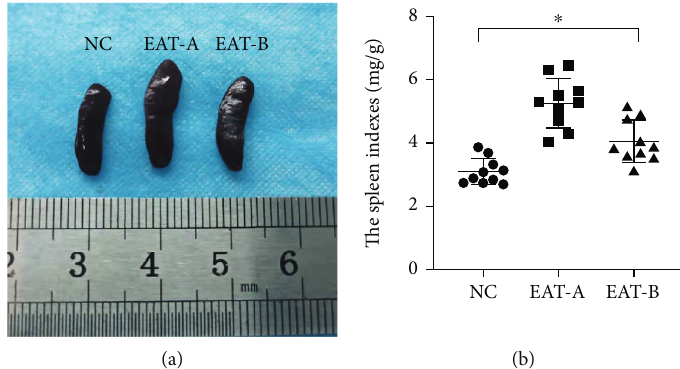
Figure 4: Spleen size and spleen index of mice at the end of the experiment. (a) Comparison of spleen size among the three di ff erent groups. (b) Comparison of the spleen index among the three groups ( F = 28 : 703 , ∗ P < 0 : 001 , one-way ANOVA). Similar to the spleen size, the spleen index in EAT-A mice was signi fi cantly increased compared to NC mice ( 5 : 26 ± 0 : 78mg/g vs. 3 : 10 ± 0 : 41mg/g , P < 0 : 001 , LSD test), and EAT-B mice had a lower spleen index ( 4 : 07 ± 0 : 67 mg/g ) than EAT-A mice ( P < 0 : 001 , LSD test) but higher than that of NC mice ( P = 0 : 002 , LSD